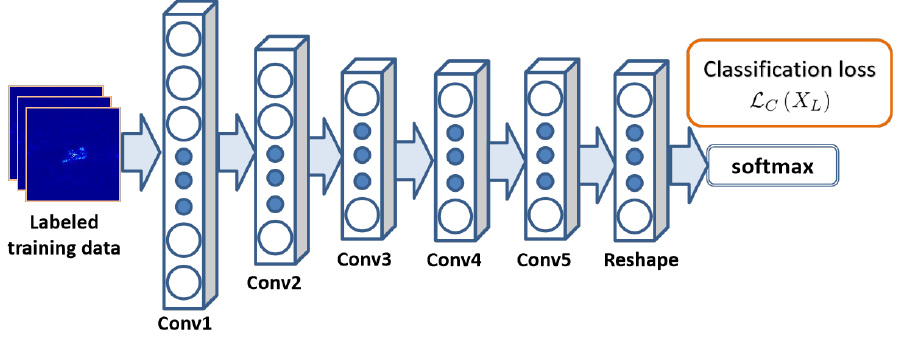
Figure 3. Basic recognition